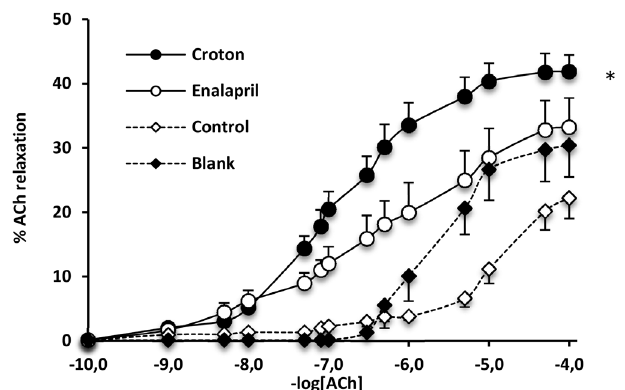
FIGURE 2 - Cumulative (10 -10 - 10 -4 M) Acetylcholine dose- response curves in intact aorta rings prepared from Wistar rats previously treated with: (1) ethanolic extract of Croton